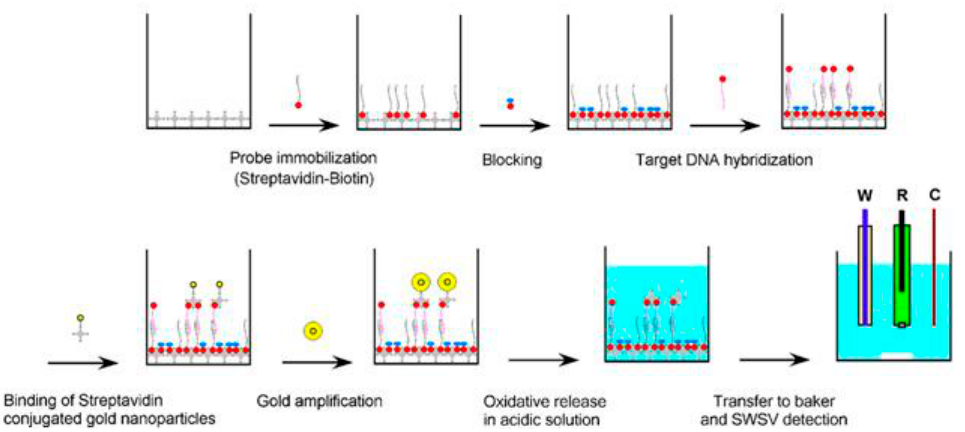
Figure 2. Schematic illustration of DNA bioassay using AuNPs as labels and their SWSV determination at glassy carbon working electrode. Biotinylated DNA probe immobilized on a streptavidin-coated microwell, which was hybridized with biotinylated target while streptavidin-conjugated AuNPs bound on target DNA, followed by dissolution in acid solution and detection by SWSV method. Reproduced from [48], with permission from Elsevier, 2019.